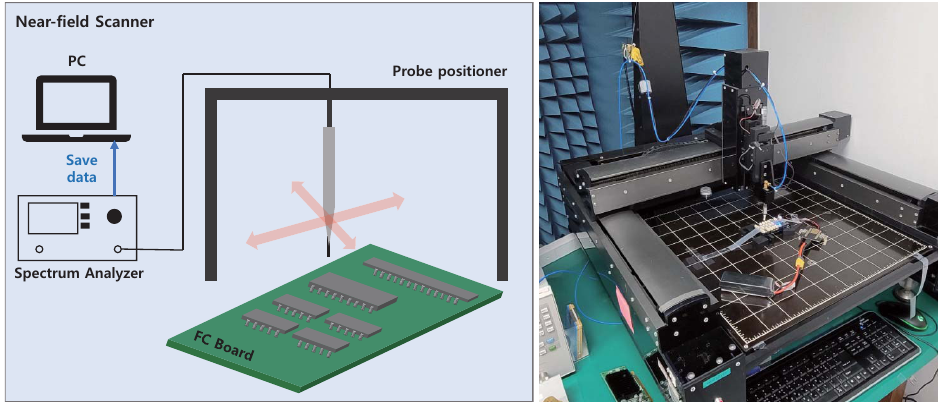
Figure 4. Diagram and experimental setup of near-field scanner.